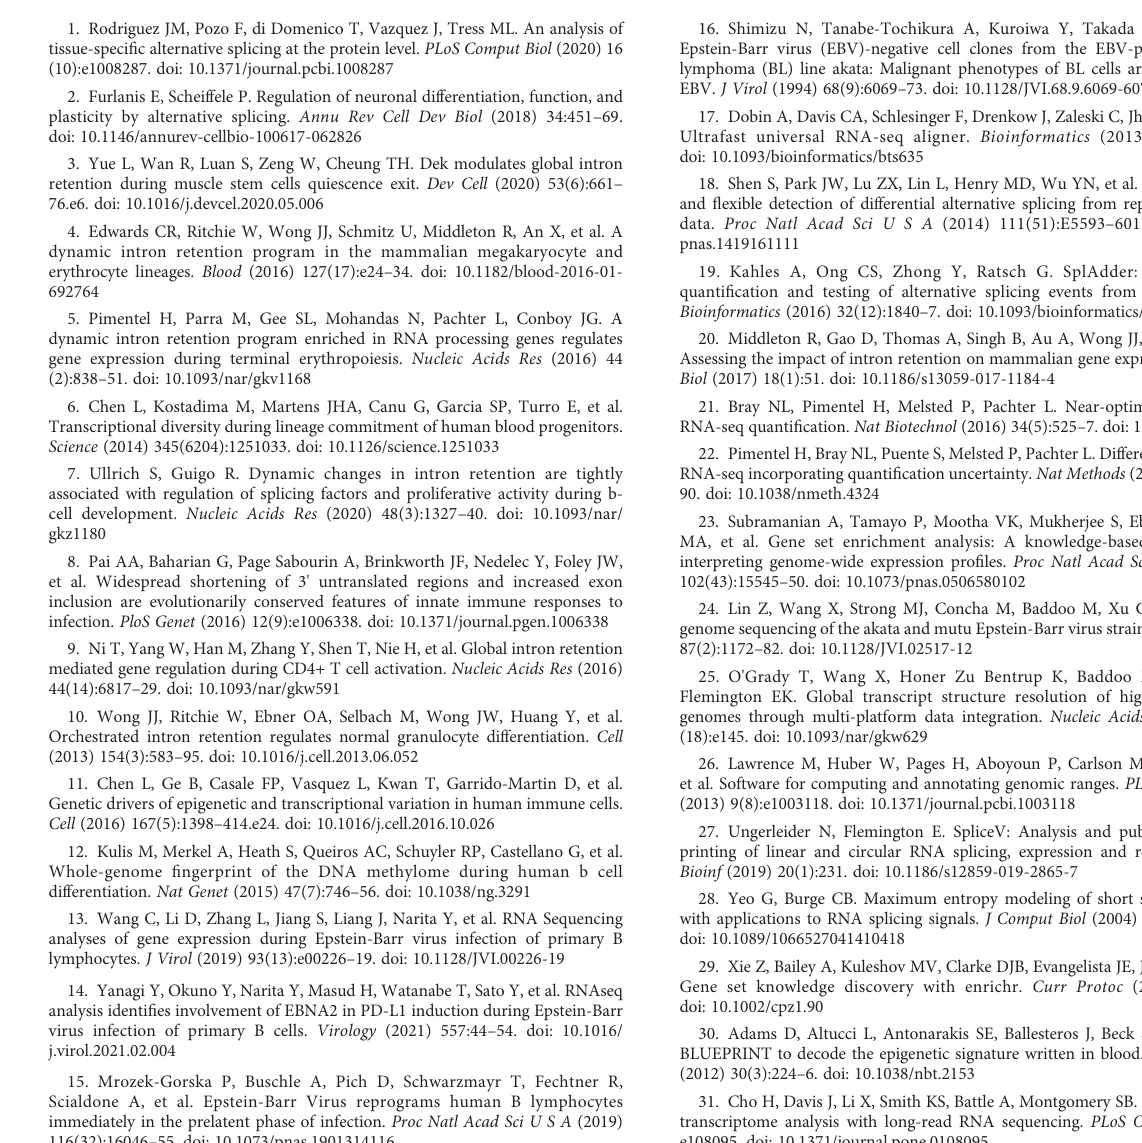
SUPPLEMENTARY TABLE 7 Gene Ontology Biological Process term enrichment (from Enrichr) in genes with protein domains restored or NMD targeting reduced by exon inclusion in differentiated or EBV-infected cells. The top 10 terms with lowest adjusted p-value for each experiment/timepoint are shown. SUPPLEMENTARY TABLE 8 Gene Ontology Biological Process term enrichment (from Enrichr) in genes with restored protein domains or reduced NMD targeting in tonsil NBCs (tNBCs) compared to blood NBCs (bNBCs) and in PCs compared to bNBCs. SUPPLEMENTARY TABLE 9 Adjusted p-values from rMATS for altered exon usage in genes in